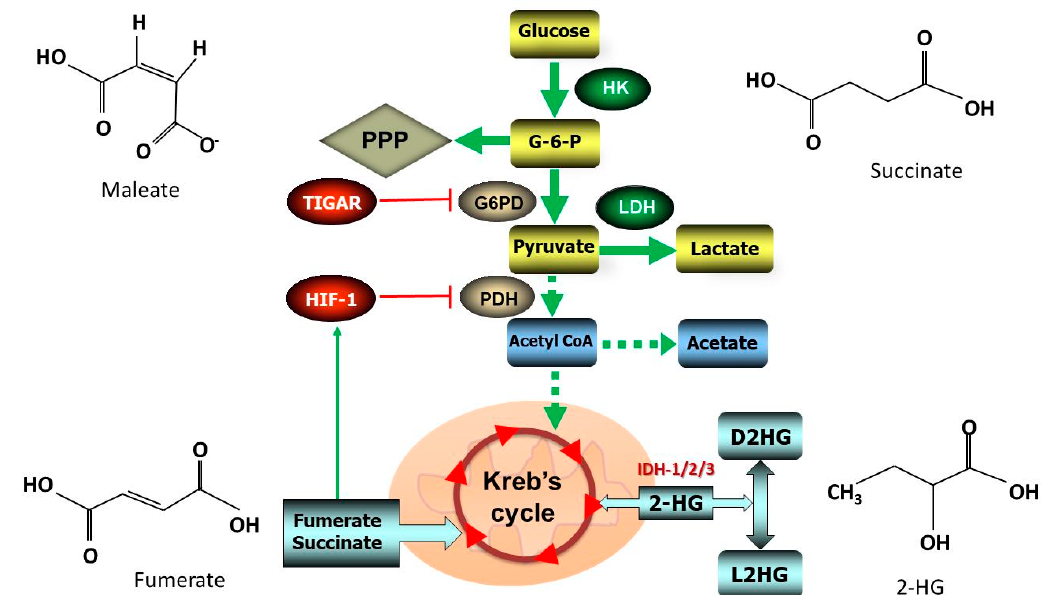
Figure 2. Metabolic regulation of antioxidants: Highly proliferative cancer cells rely on glycolysis to meet its exceedingly high energy demands. Activation of Hypoxia inducible factor-1 (Hif-1) cause the suppression of Pyruvate Dehydrogenase (PDH) resulting in the opening up of glucose transporters and increase in the flux of glucose in glycolytic cycle. During hypoxia, Hif-1 switches cell gene expressions from glycolysis to production and utilization of lactates (Warburg e ff ect). The oncometabolites, fumerate and succinate may act on Hif-1 for inducing a ‘pseudohypoxic’ response. Besides, mutations in p53 attenuate TP53-induced Glycolysis and Apoptosis Regulator (TIGAR) causing a lack of inhibition on the Glucose-6-Phosphate Dehydrogenase (G6PD) enzyme activity leading to the increase in the metabolic flux through glycolytic and Pentose Phosphate Pathway (PPP). The D-2-hydroxyglutarate (D2HG) and the L-2-hydroxyglutarate (L2HG) are enantiomers of the metabolite 2-HG arising from the mutations in the Isocitrate Dehydrogenase 1 / 2 / 3 (IDH1 / 2 / 3). Eventually, these changes may cause altered metabolic flux responsible for the initiation of neoplasms. Thick solid lines indicate strong and dotted lines indicate weak flux of metabolites. Abbreviations: HK, Hexokinase; G-6-P, Glucose-6-Phosphate;